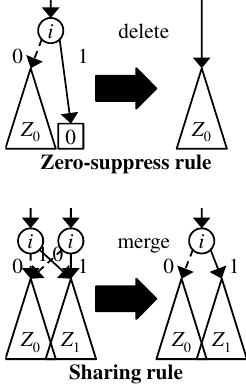
Figure 2. Reduction rules of ZDDs.